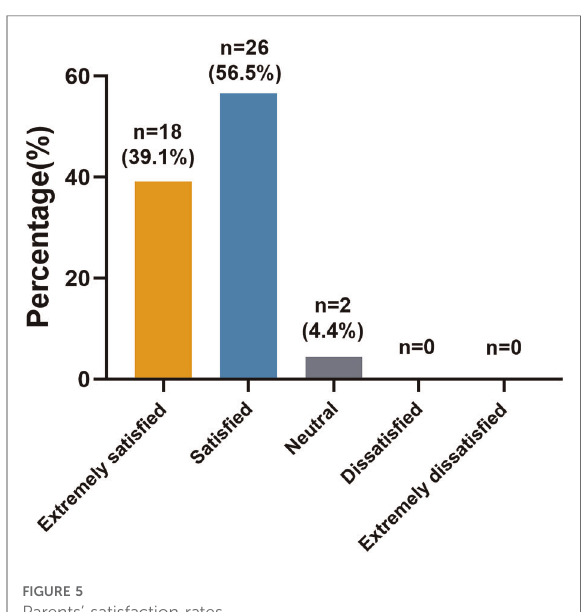
FIGURE 5 Parents ’ satisfaction